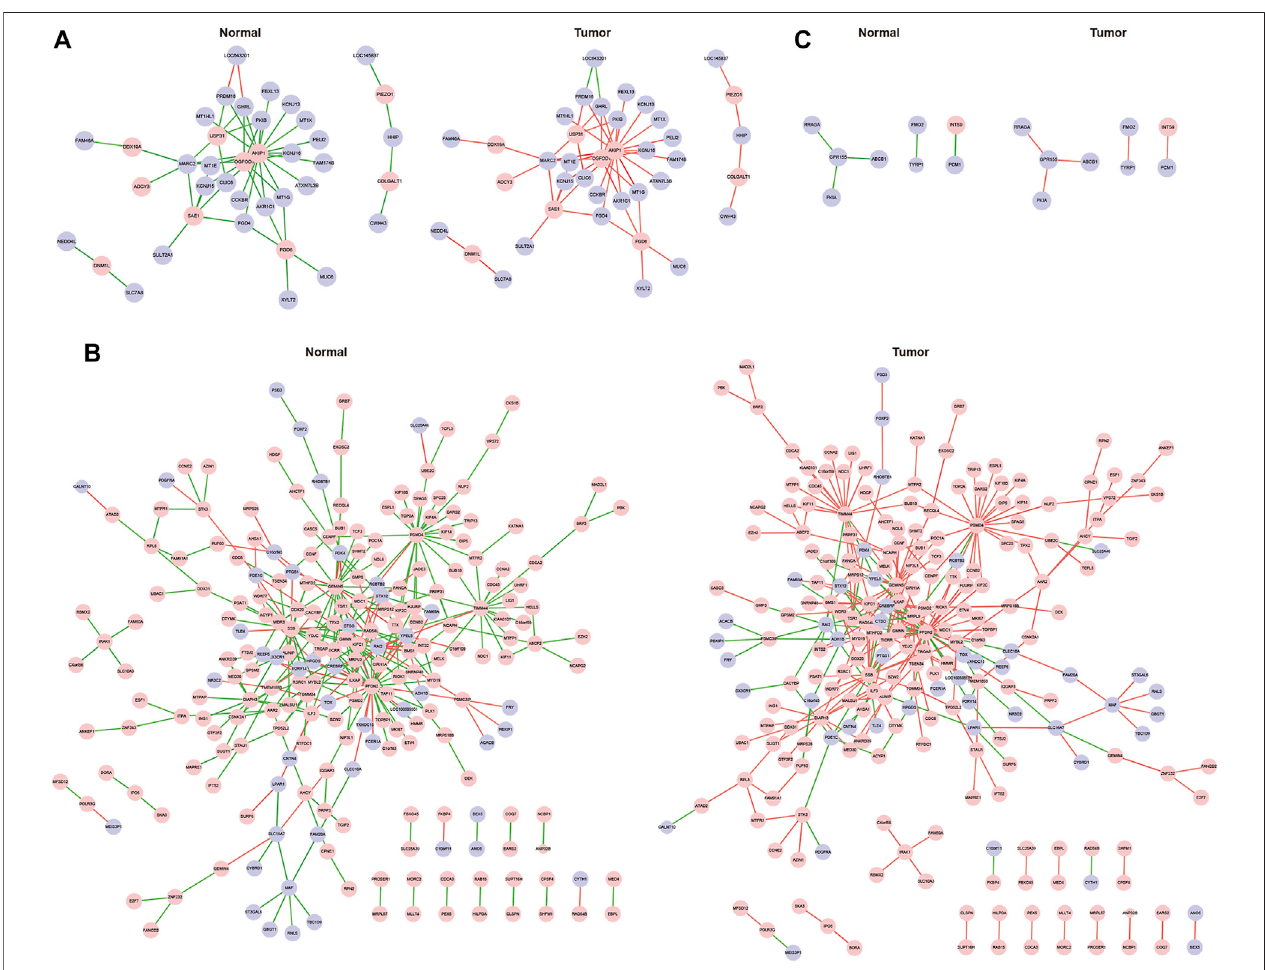
FIGURE5| Differentiallyco-expressedgenenetworksinthepink (A) ,turquoise (B) andblue (C) modules.Eachnoderepresentedagene,withlavender- fi lledcolor denoting decreased genes and pink- fi lled color denoting increased genes in GC. The edge represented connection between two genes. The green edge represented negative correlation and red positive